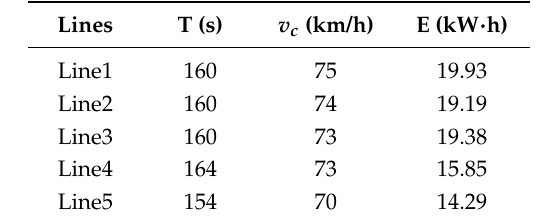
Figure 9. Energy-efficient driving strategy for the train running in Line 1 with T = 160 s. Table 5. The optimal cruising speed v ∗ c and energy consumption E of each line with a planned trip time T .